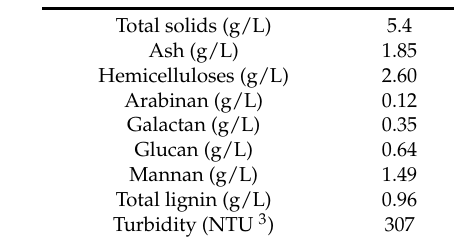
Table 1. Characteristic composition of the ThMP 1 process water. The process water was analyzed in accordance with the standardized NREL 2 laboratory analytic procedure